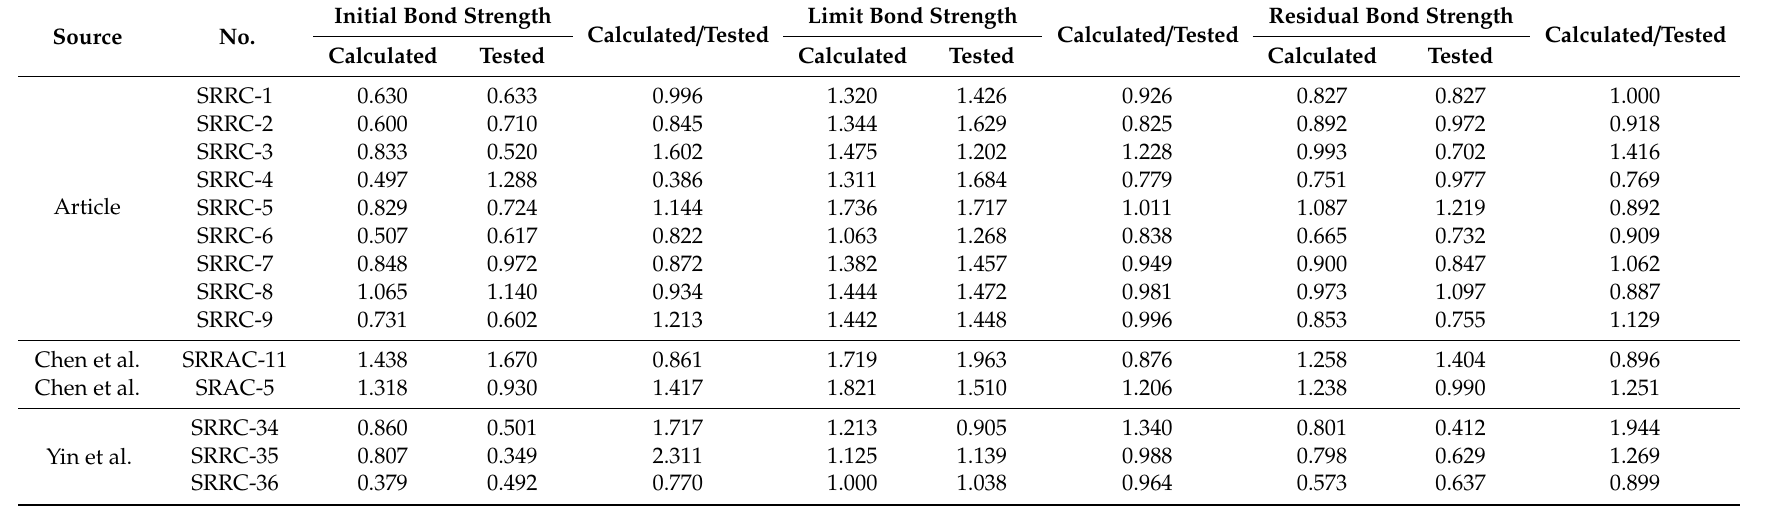
Table 6. Comparison of characteristic bond